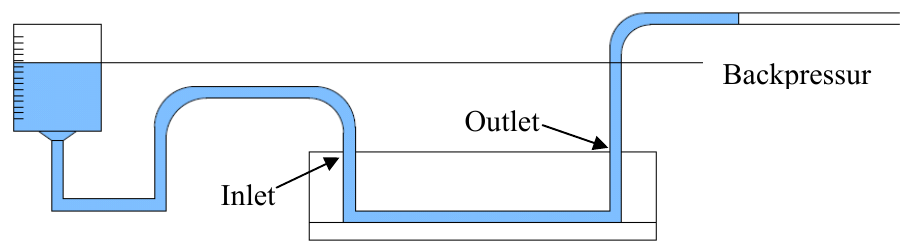
Figure 6. Schematic of the experiment setup for measuring flow rates.